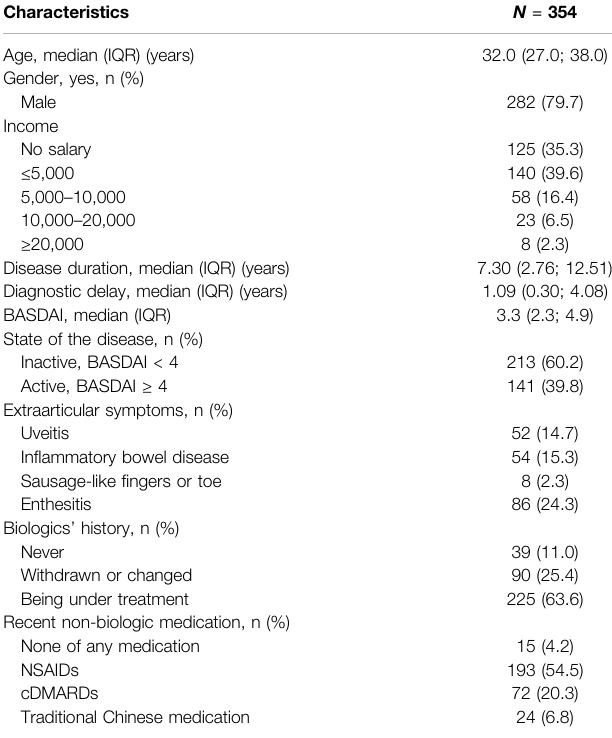
TABLE 1 | Characteristics of the